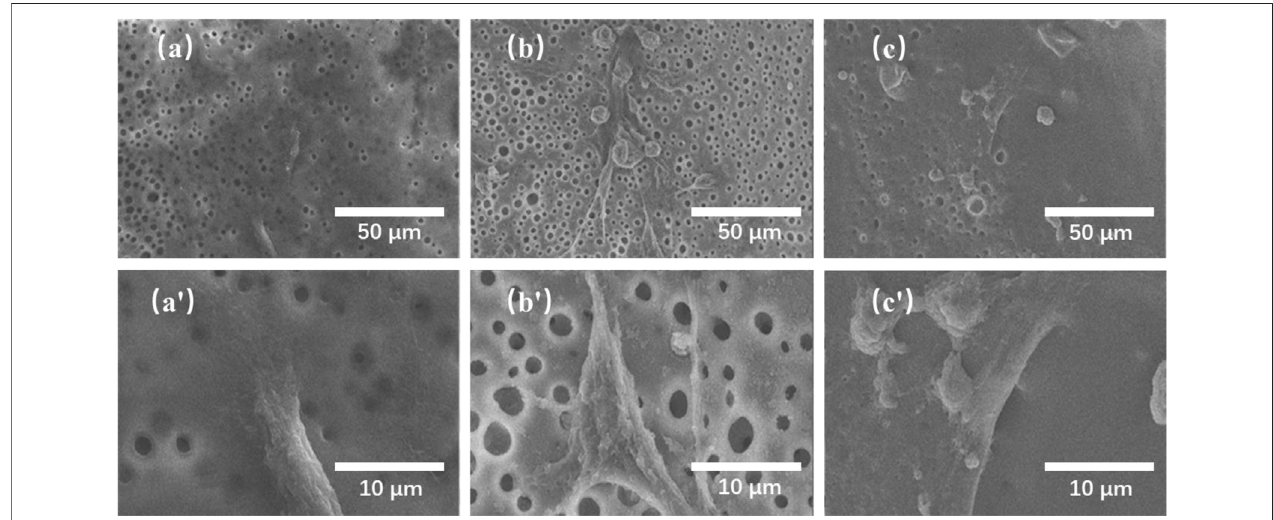
FIGURE 8 | SEMimagesofratbonemarrowstromalcells(rBMSCs)culturedontheTMBG (A,A 9 ) ,TMBG-PDTEC8 (B,B 9 ) ,andTMBG-PDTEC16 (C,C 9 ) scaffoldsfor1 day.